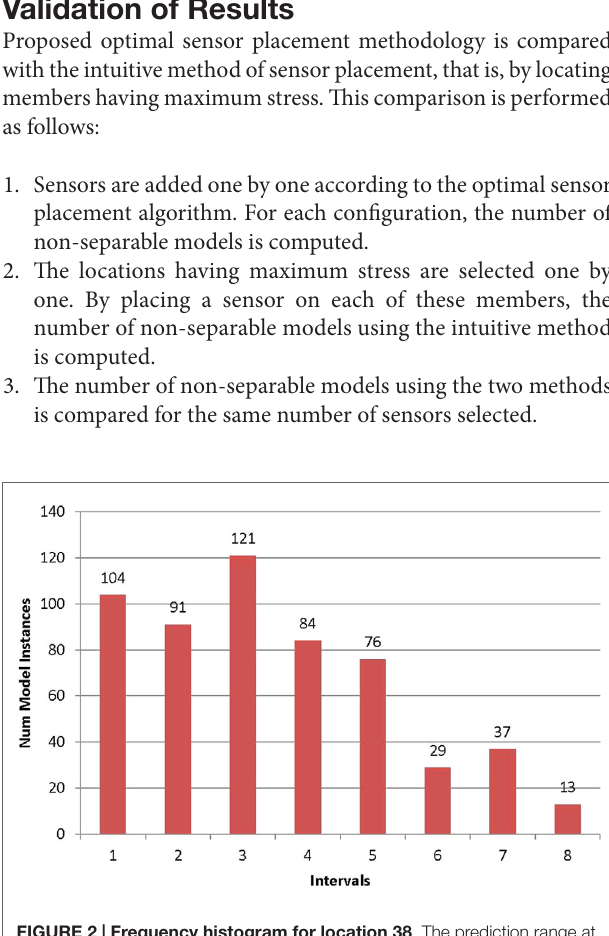
FigUre 2 | Frequency histogram for location 38 . The prediction range at this location is divided into intervals of equal width according to the estimate of error threshold. The horizontal axis represents the interval number and the vertical axis the number of models lying in the